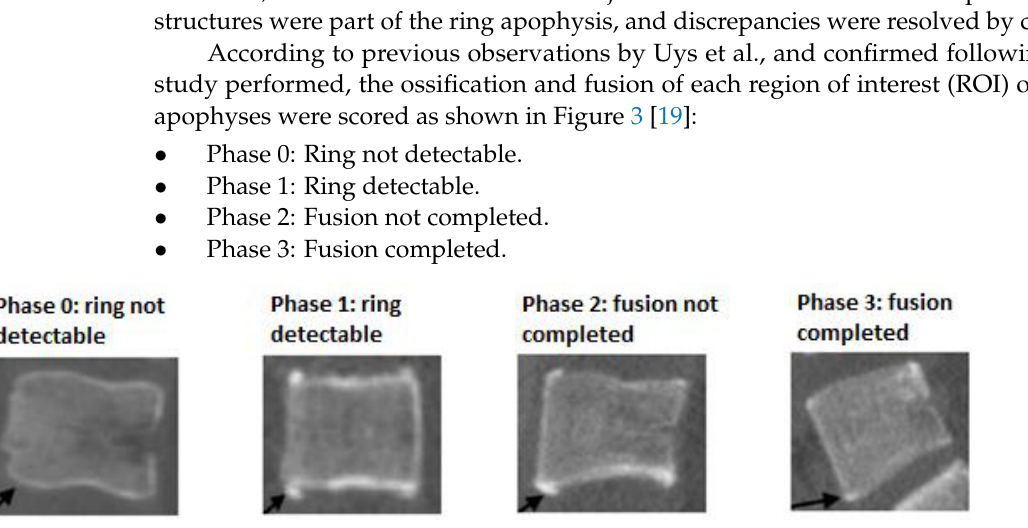
Figure 3. The four phases of maturation of the ring apophysis on mid-sagittal images. In phase 0 the rings are still in a cartilaginous stage and are not detectable on CT scans. In phase 1 the rings are ossified and can be seen on CT scans but have not yet started to fuse. In phase 2 the rings are starting to fuse with the bodies. In phase 3 the rings are completely fused with the vertebral bodies.